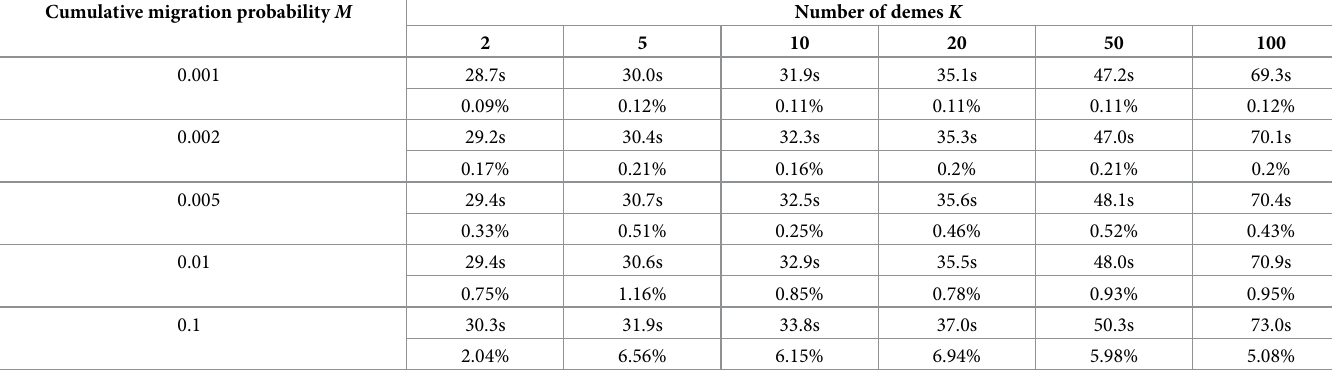
Table 3. Run time to generate 10 million events. The second number is the percentage of discarded events (due to migration acceptance/rejection). There are 16 = 4 2 hap- lotypes and 3 susceptible compartments. The sampling rate is set to z = 0.1, recovery rate is ρ = 0.9, transmission rate is λ = 2.5. The tests were run on a server node with Intel Xeon Gold 6152 2.1–3.7 GHz processor and 1536GB of